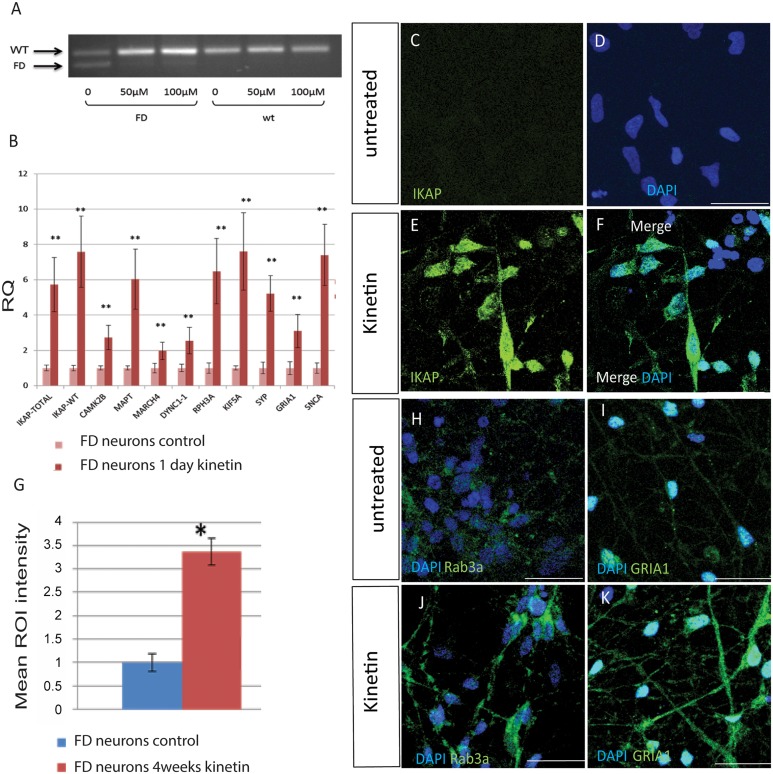
Rescue effect of kinetin on IKBKAP expression and concomitantly on in FD-hESC derived PNS neurons.(A) RT-PCR results of one day kinetin treatment on FD-hESC derived PNS neurons showing the drug correcting effect on FD alternative splicing. (B) qRT-PCR analysis of the relative quantification levels represented as mean ± s.d. of IKBKAP and co-regulated functional candidates in FD neurons following one day kinetin treatment. * P<0.05 **P<0.01. (C-K) Effect of 4 weeks kinetin treatment on the expression of IKAP in FD-hESC derived PNS neurons (C-D, untreated and E-F, 4 weeks kinetin treated by immunofluorescence confocal analysis. (G) Quantification of IKAP mean levels calculated from mean RGB after 4 weeks kinetin treatment on these cells (C-K). * P<0.05. (H-K) Effect of 4 weeks kinetin treatment (J and K) on the expression of Rab3a (H and J) and GRIA1 (I and K) in FD-hESC derived PNS neurons by immunofluorescence confocal analysis. Mouse anti-hIKAP antibody (Abnova Corporation) was used in these experiments.